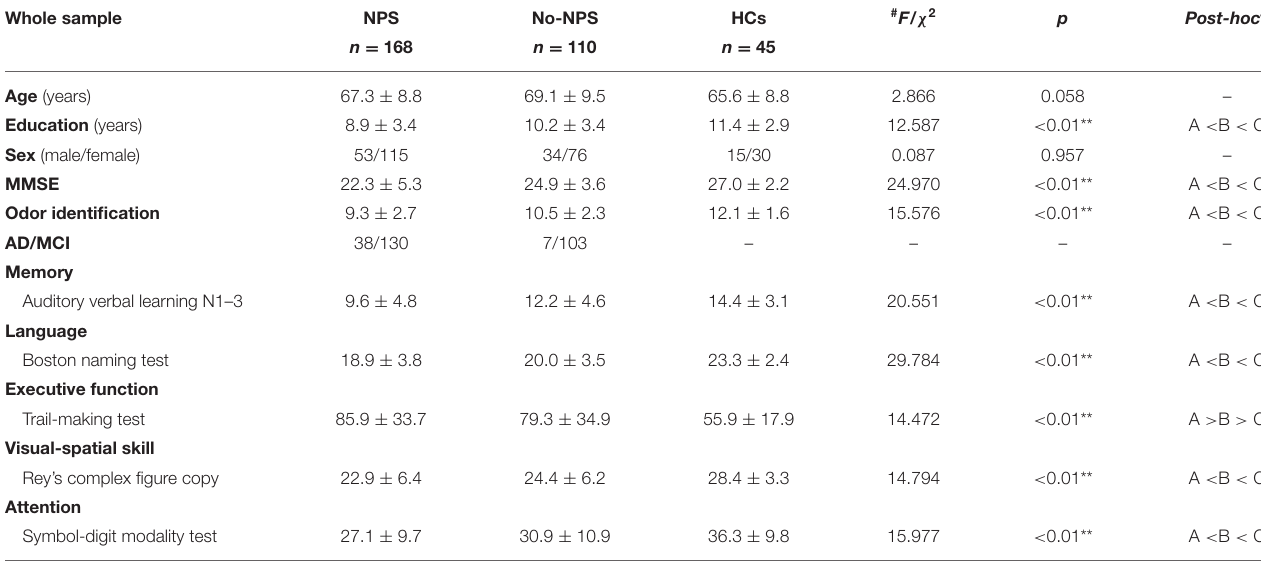
TABLE 1 | Demographic, olfactory, and cognitive information of NPS and No-NPS patients.